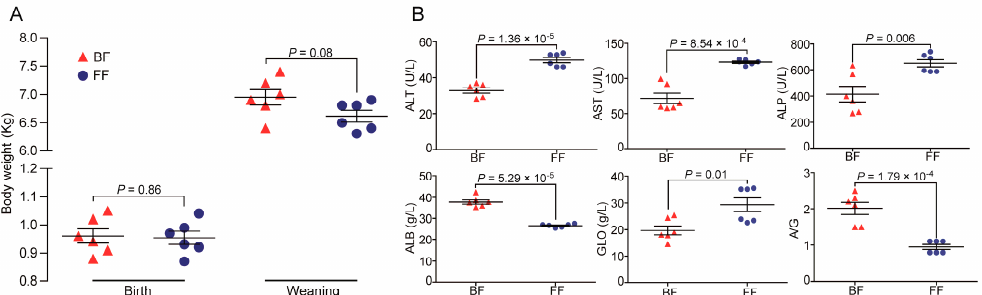
Figure 1. Phenotypic differences: ( A ) Body weights; ( B ) Serum metabolism indicators.